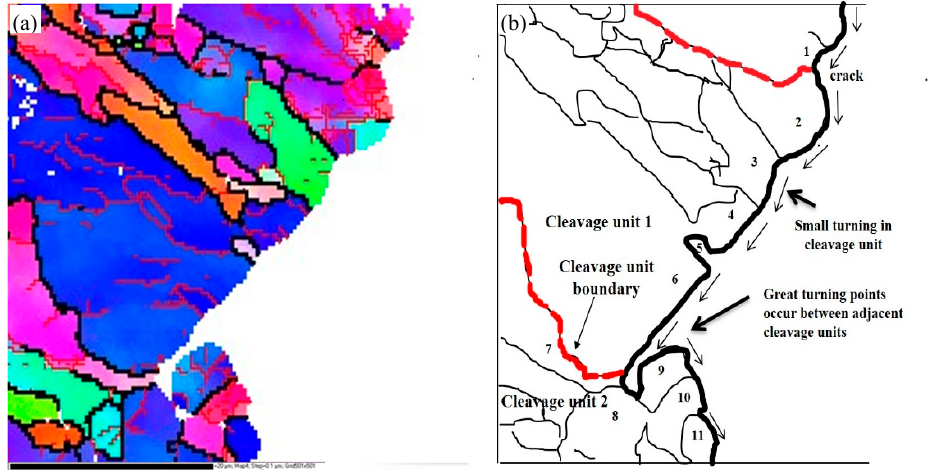
Figure 14. Orientation and schematic map of Charpy impact crack propagation: ( a )orientation map of Charpy impact crack propagation, ( b ) schematic map of Charpy impact crack propagation according to Figure 14a.